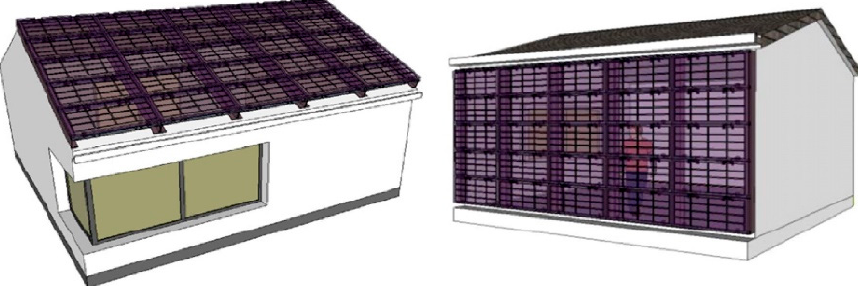
Figure 9. Architectural representation of BIPV. Reprinted/adapted with permission from Ref. [56]. 2016, Elsevier.